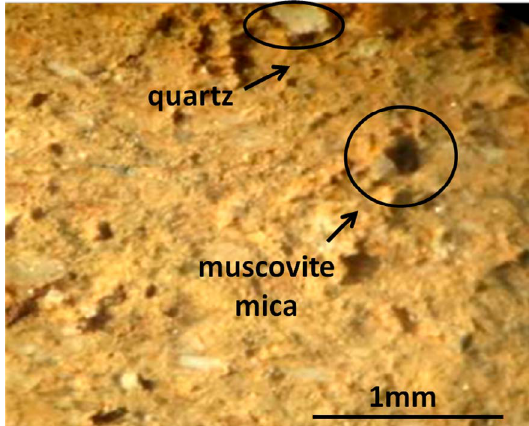
Figure 10. Fracture surface of the ceramic with 10 wt% of incorporated Sulfatreat